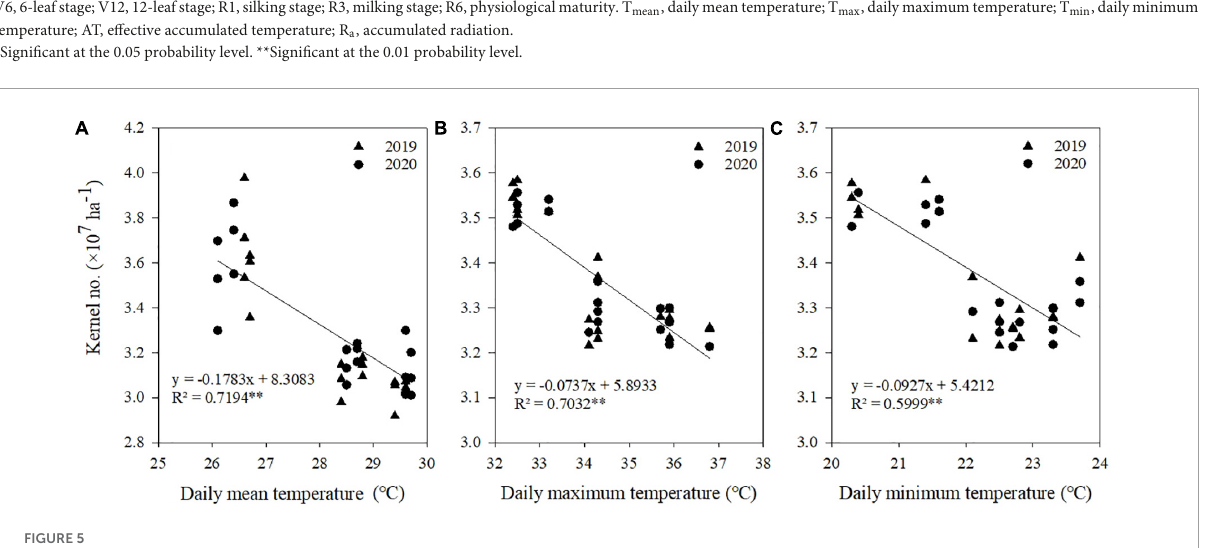
photosynthetic activity (e.g., higher SPAD, F v /F m , P n , T r , and G s ). As a result, the pre-silking DM accumulation for SD1 and the post-silking DM accumulation for SD3 averagely increased by 17.9 and 8.4% compared to SD2,